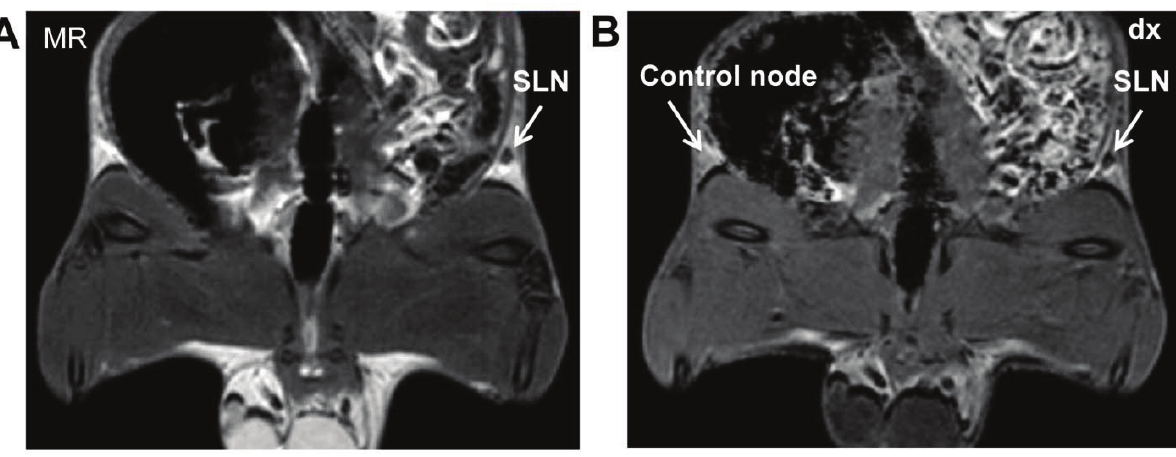
Figure 2. Representative coronal MR images of white Wistar rat injected subcutaneously with 99m Tc-AF-SPIONs in the right hind paw. Accumulation of the 99m Tc-AF-SPIONs in SLN can clearly visualized using ( a ) SE and ( b ) GRE sequences (white